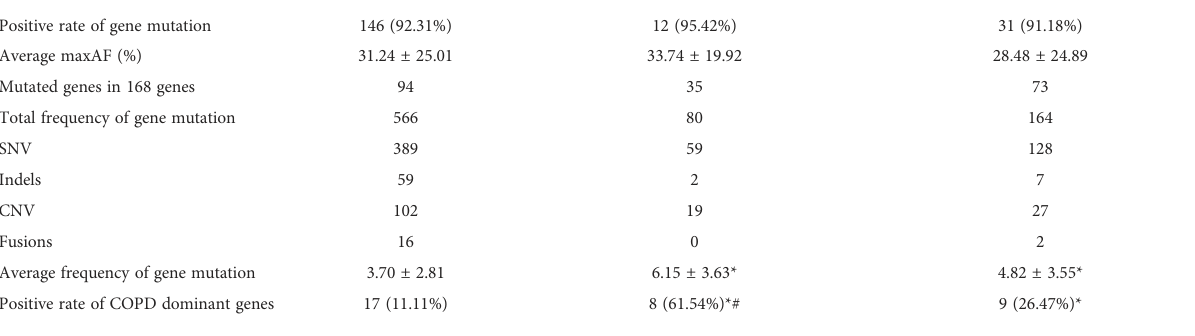
TABLE 2 Gene mutation pro fi les of the NSCLC sub-cohort with FFPE tDNA samples (N=200).